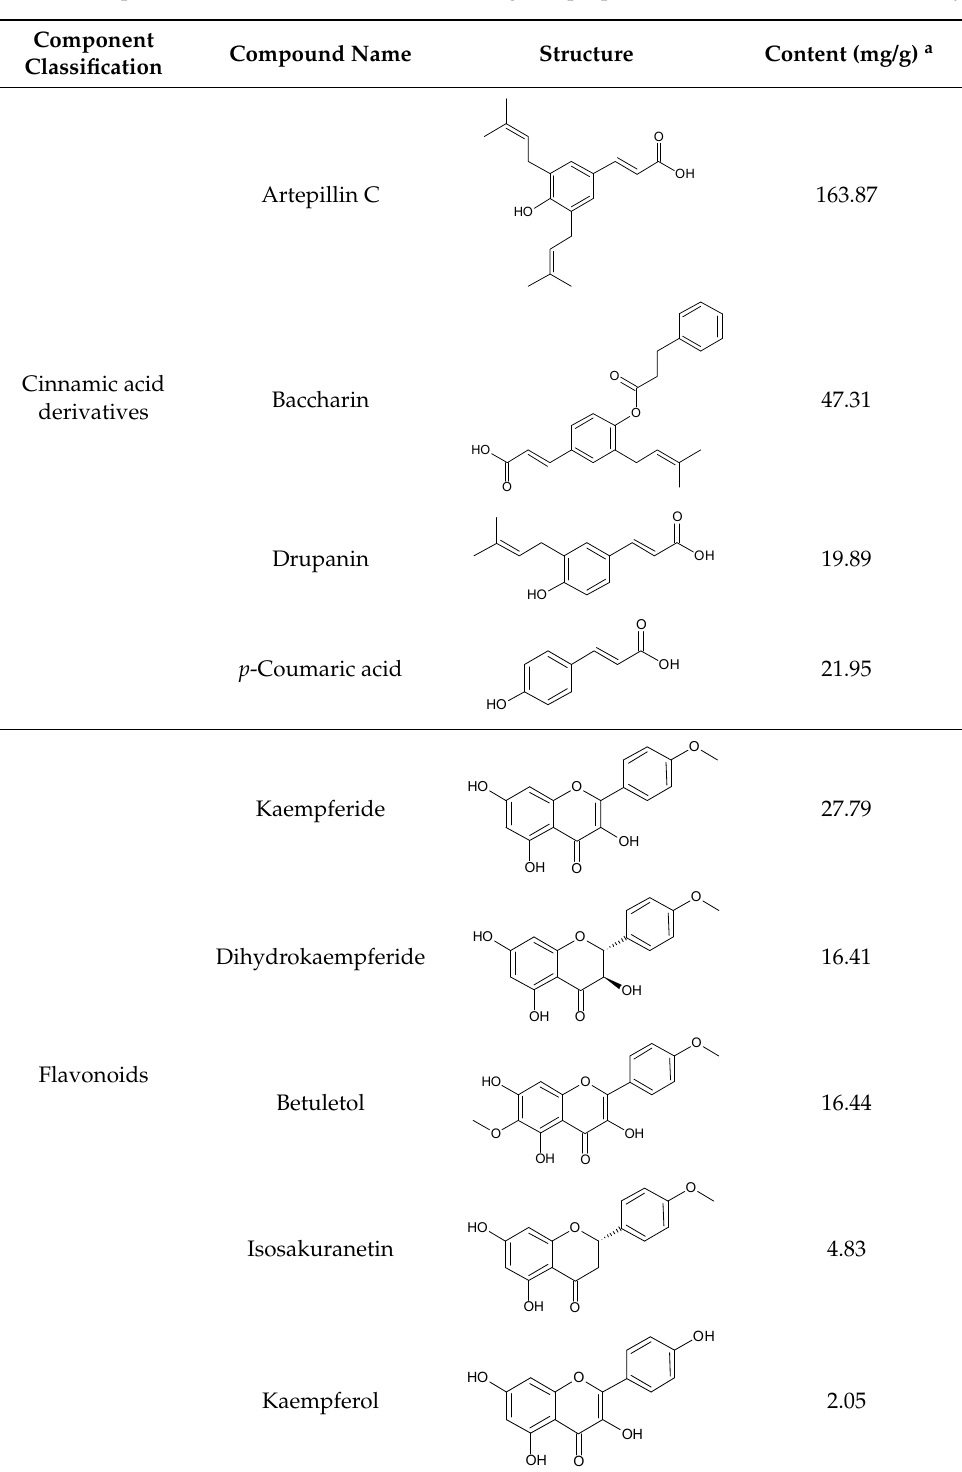
While BGP is used in a variety of products such as cosmetics, its safe concentration has not yet been scientifically confirmed. Table 2. Components and their contents in Brazilian green propolis (BGP) used in the current Table 2. Components and their contents in Brazilian green propolis (BGP) used in the current study. Table 2. Components and their contents in Brazilian green propolis (BGP) used in the current study. Table 2. Components and their contents in Brazilian green propolis (BGP) used in the current study. Table 2. Components and their contents in Brazilian green propolis (BGP) used in the current study. Table 2. Components and their contents in Brazilian green propolis (BGP) used in the current study. Table 2. Components and their contents in Brazilian green propolis (BGP) used in the current study. Table 2. Components and their contents in Brazilian green propolis (BGP) used in the current study. Table 2. Components and their contents in Brazilian green propolis (BGP) used in the current study. Table 2. Components and their contents in Brazilian green propolis (BGP) used in the current study. Component